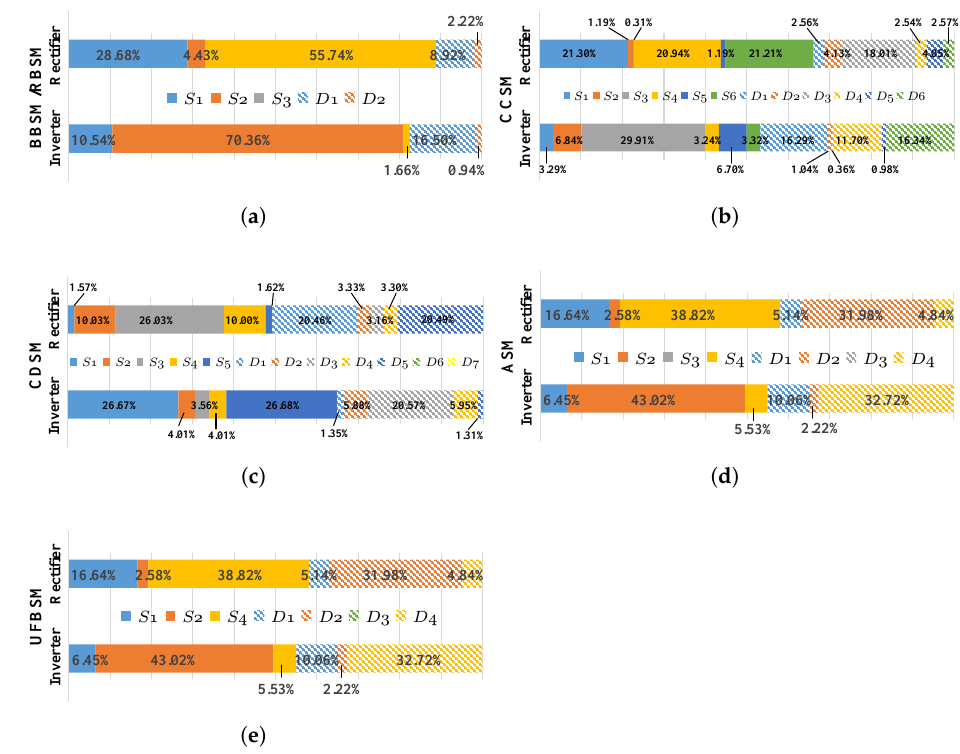
Figure 25. Loss distribution amongst SM devices: ( a ) BBSM/RBSM, ( b ) CCSM, ( c ) CDSM, ( d ) ASM, and ( e )